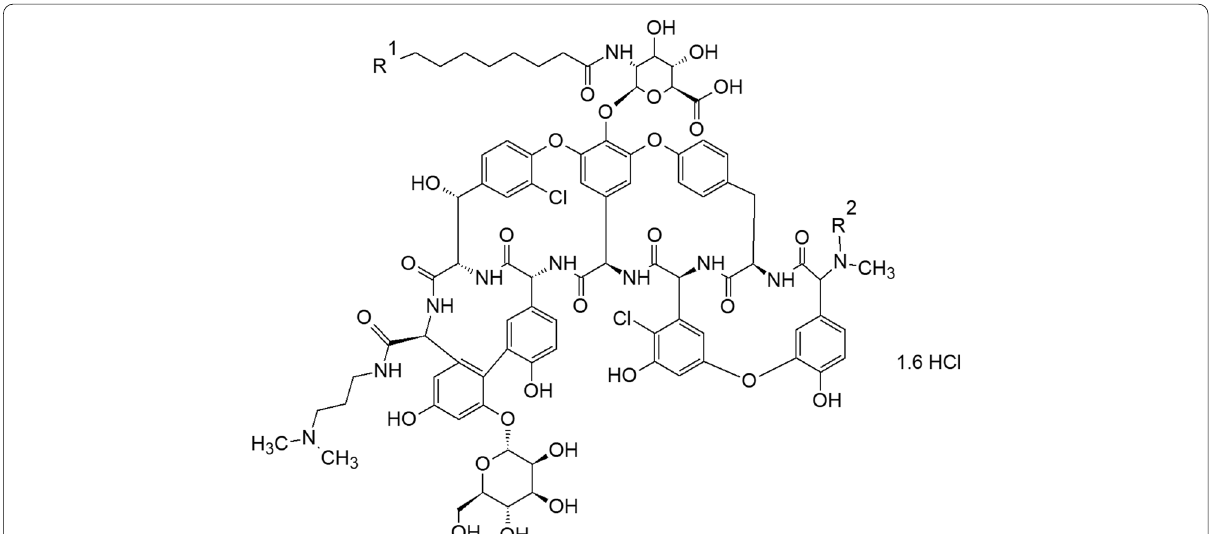
Fig. 8 Structural formula of dalbavancin. The structures of the R 1 and R 2 groups for the different homologs of dalbavancin are given in Table 3 [24, 25]